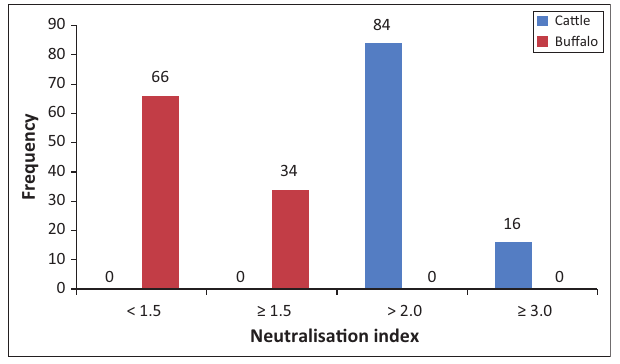
FIGURE 1: Results of neutralisation index for lumpy skin disease virus from 100 cattle and 100 buffalo.